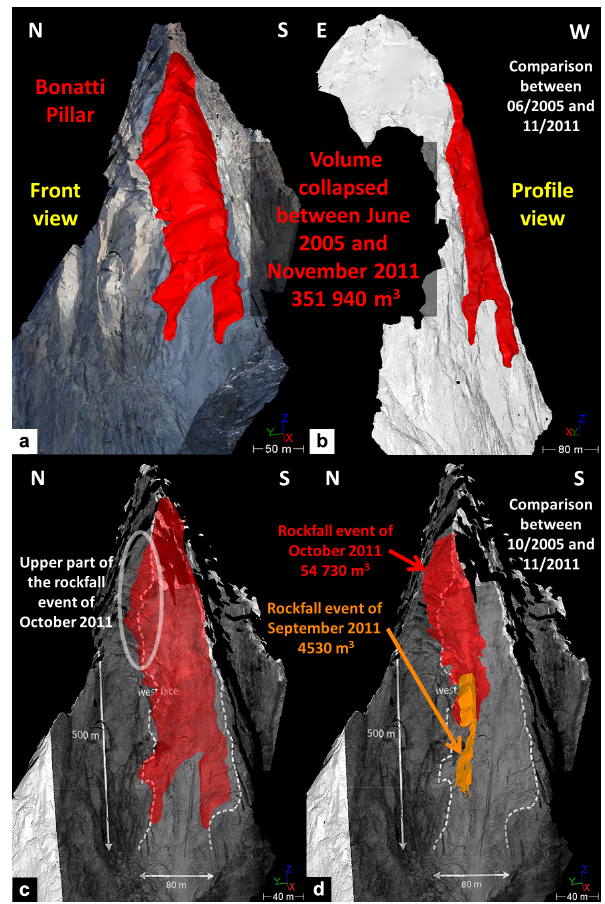
Figure 7. 3-D geometry of the volumes that collapsed between June 2005 and November 2011. (a) Photorealistic model of the Drus west face (high-resolution lidar mesh textured with a picture of November 2011) and front view of the volume (in red) calcu- lated with 3DReshaper. (b) Profile view of the high-resolution lidar mesh (non-textured) as well as the volume shown in Fig. 4a. (c) Su- perimposition of the volume that collapsed between June 2005 and November 2011 with another photorealistic model, textured from the left part of the Fig. 8 of Fort et al. (2009). The white dashed line shows the scar limits of the June 2005 rock avalanche, and the white ellipse illustrates the area that corresponds to the upper part of the October 2011 rockfall event. (d) Superimposition of the rockfall events that occurred in September (in orange) and October 2011 (in red) with the same photorealistic model as